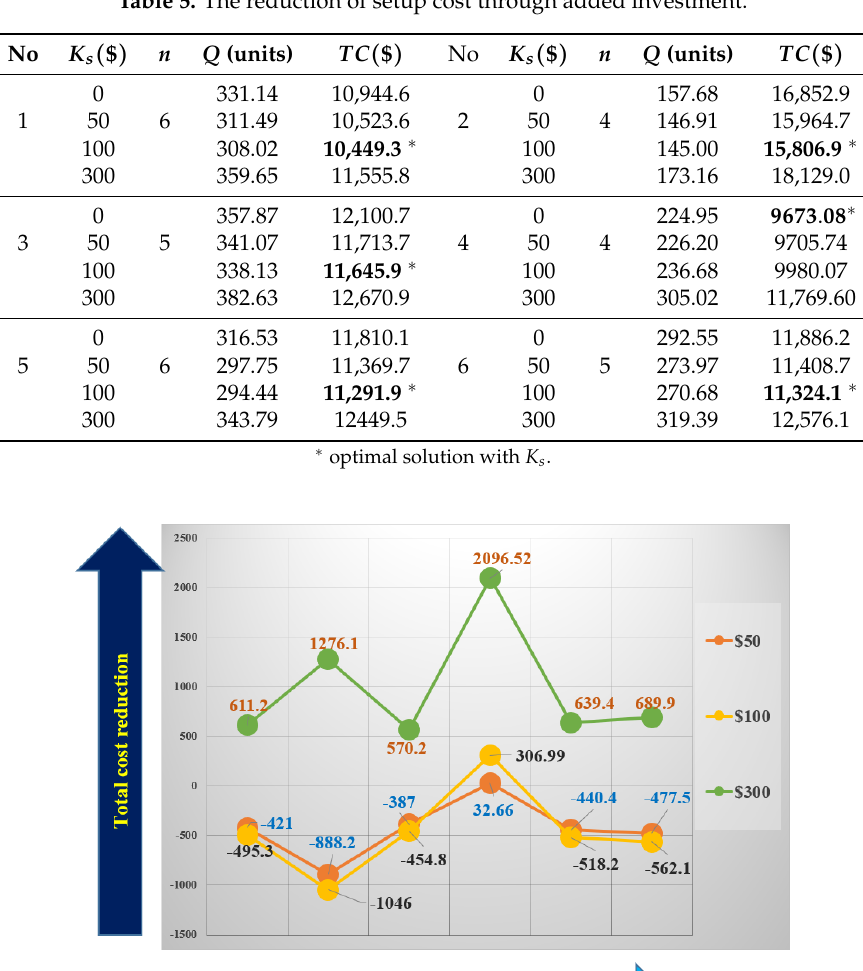
Table 5. The reduction of setup cost through added investment.